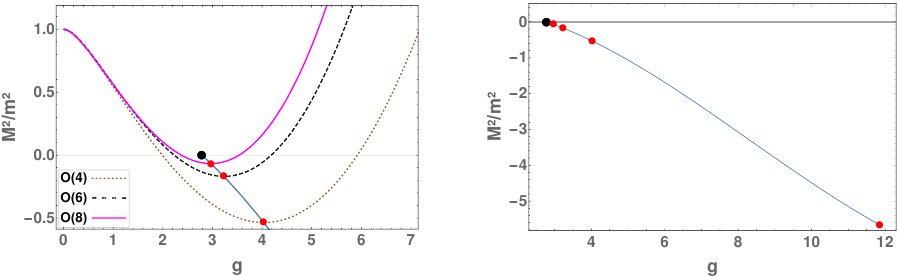
Figure 6 . Left panel: the physical mass squared, in units of m 2 , as a function of g at even orders. For clarity the order- g 2 result is not shown in this panel. Right panel: location of the minima from O (2) to O (8) (light dots). The dark dot locates the extrapolated minimum corresponding to an arbitrarily high